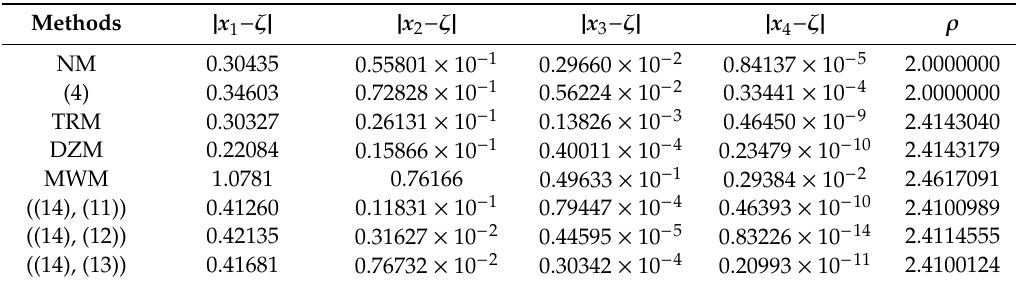
Table 3. Numerical results for function f 3 ( x ) .